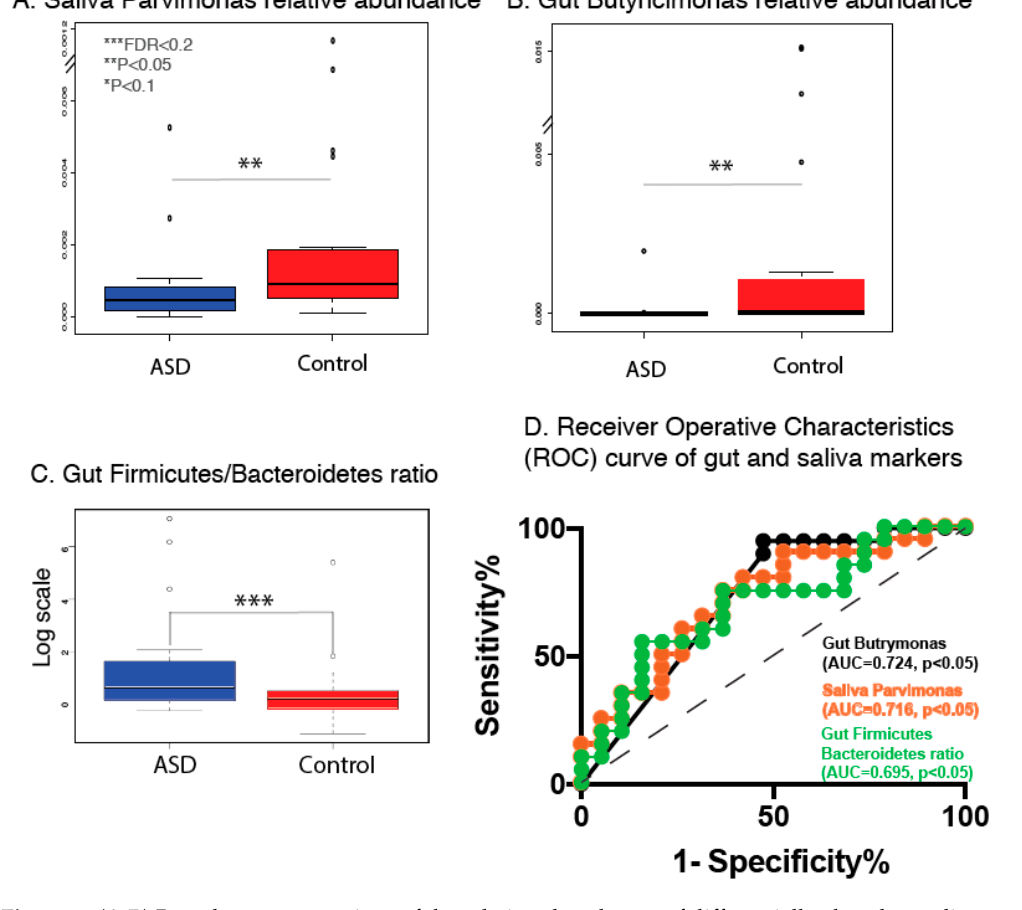
Figure 3. ( A , B ) Box plot representations of the relative abundances of differentially abundant salivary or gut bacterial genera in patients with Autism Spectrum Disorder (ASD) and control subjects. ( C ) Box plots representation of gut phylum-level dysbiosis marker Firmicutes/Bacteroidetes ratio, in patients with ASD and control subjects. ASD and neurotypical subjects are colored in blue and red, respectively. Single asterisk indicates p < 0.1 with adjusted FDR > 0.2; double asterisk indicates p < 0.05 with adjusted FDR > 0.2, triple asterisk indicates p < 0.05 and adjusted FDR < 0.2, Kruskal–Wallis test. ( D ) receiver operator characteristics (ROC) curve of the 3 differentially abundant gut or oral genera and dysbiosis markers that have the highest area under the curve (AUC), and p < 0.05 based on two-sided Z-test for ROC.